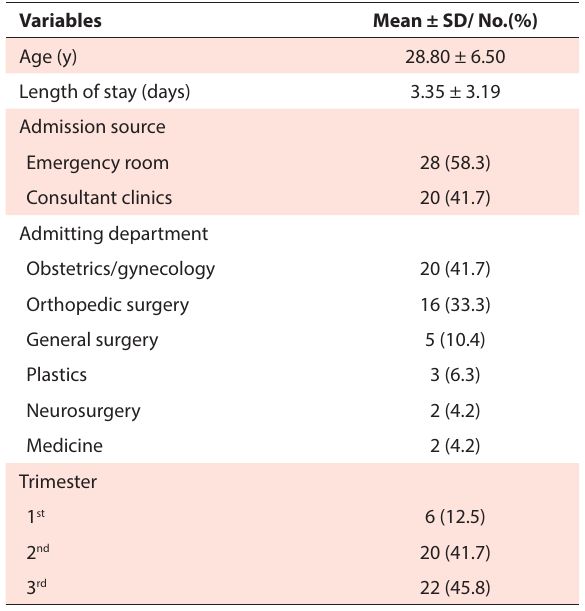
Table 1. Maternal and fetal characteristics (n =